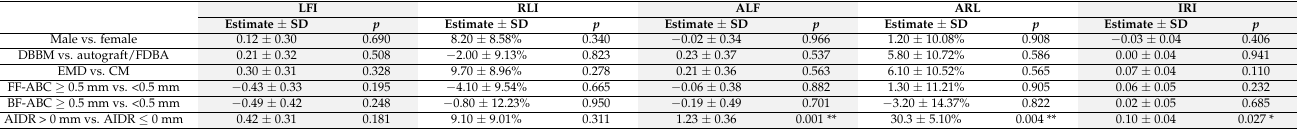
Abbreviations: LFI: the linear furcation regeneration improvement; RLI: the ratio of LFI; ALF: the adjusted LFI; ARL: the adjusted ratio of LFI; IRI: the improvement of radiographic intensity; BRG: the bone replacement graft; FDBA: freeze-dried bone matrix; DBBM: deproteinized bovine bone matrix; CM: collagen membrane; EMD: enamel matrix derivatives; FF-ABC: the distance between FF and ABC; AIDR: the adjacent intrabony defect regeneration. Significant difference: * p < 0.05, ** p <